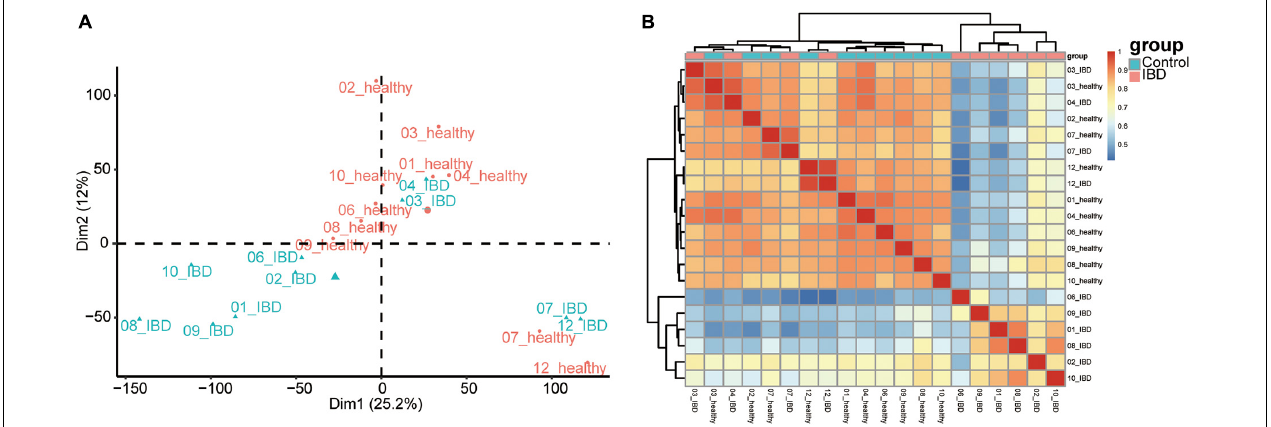
FIGURE 1 | Sample inherent similarity based on principle component analysis (PCA) and pairwise correlation analysis. (A) Scatter plot of the top two components from the PCA. (B) Sample similarity derived from the pairwise correlation analysis. Pearson’s correlation results were shown in the